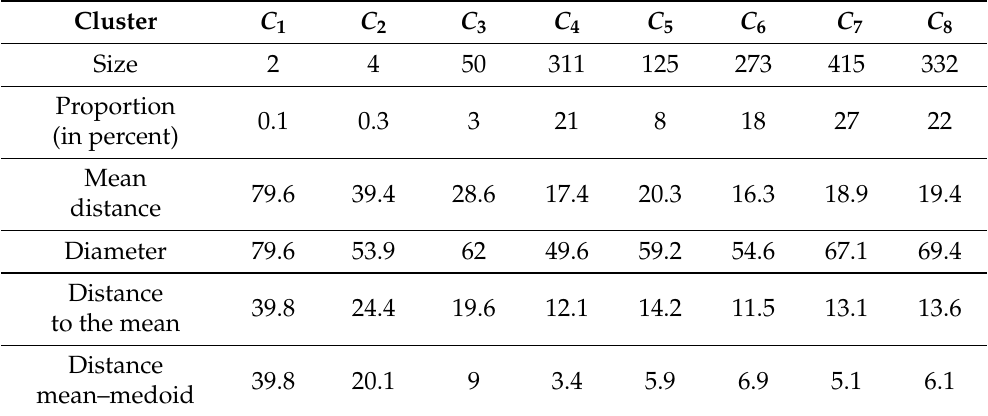
Table 3. Clustering of male body shapes.